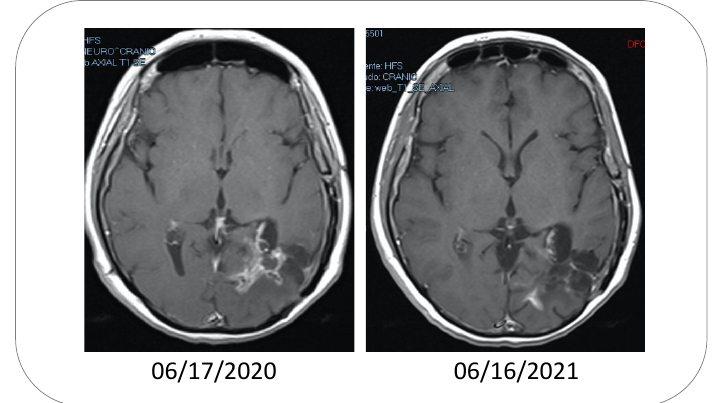
Figure 2. MRIs showing the effect of inhaling POH in a patient with relapsed GBM. Note the tumor tissue in the initial MRI on 06/17/2020, as indicated by intense non-homogeneous enhancement. One year later (06/16/2021), the lesions presented with reduced dimensions and a marked reduction in contrast enhancement, suggesting a response to the POH treatment. While these MRIs present an illustrative example derived from the group of patients who responded favorably to intranasal POH and achieved stable disease status, not all patients responded similarly well, with some patients progressing after the initial response, despite continuous treatment.